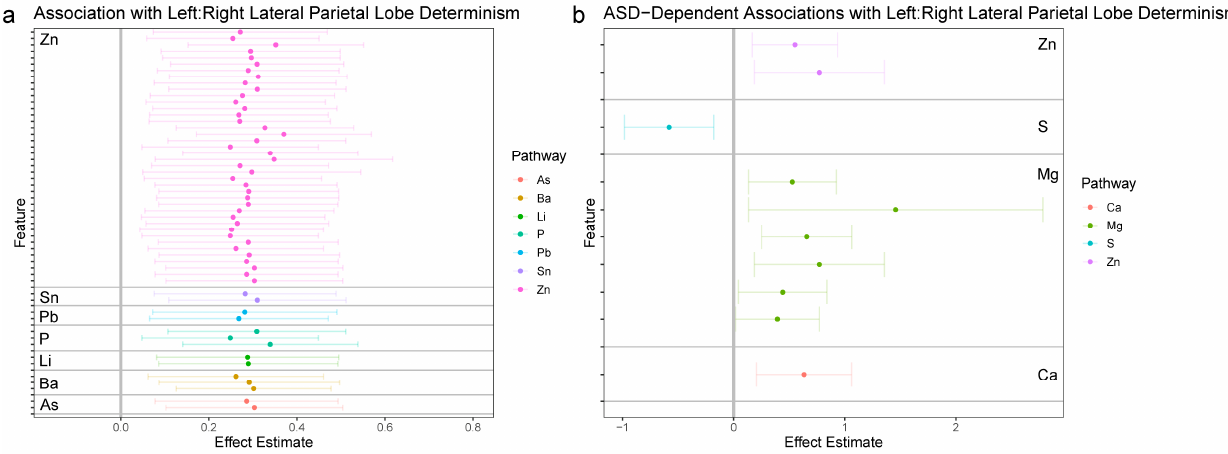
Figure 5. Associations between elemental dynamics and synchronization between left and right lateral parietal lobes. ( a ) Left panel shows effect estimates for associations between elemental features and determinism in the LP L and LP R BOLD signals; only features with significant associations following FDR-adjustment for multiple comparisons are shown. ( b ) Right panel shows effect estimates for the interaction between autism and features of elemental dynamics; features with significant associations following FDR-adjustment for multiple comparisons are shown. The magnitude of effect estimates in essence depicts the difference in a feature between participants with autism and control participants.